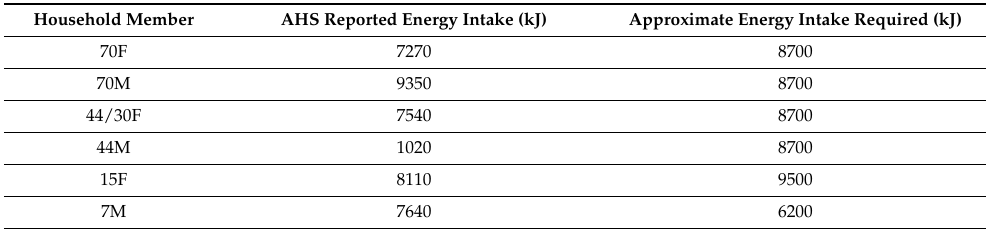
Table 3. Summary of energy requirements for all reference household family members, and in comparison to reported Australian dietary